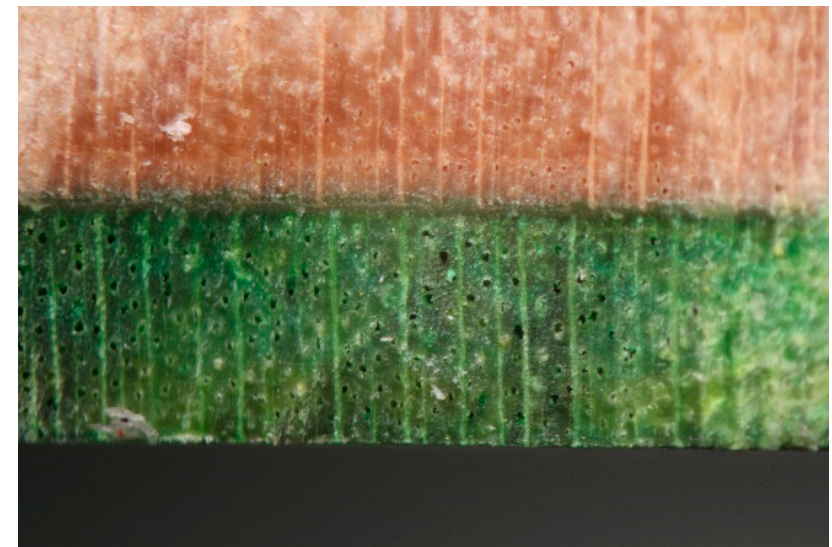
Figure 24. Species Identification Sample 4 20×.